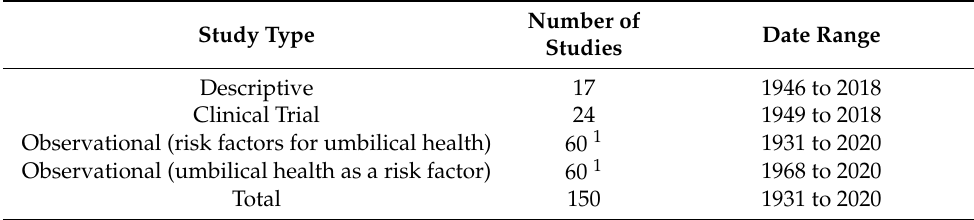
Table 2. Number of articles and date range for descriptive studies, clinical trials, observational studies examining risk factors for umbilical health, and observational studies examining umbilical health as a risk factor.